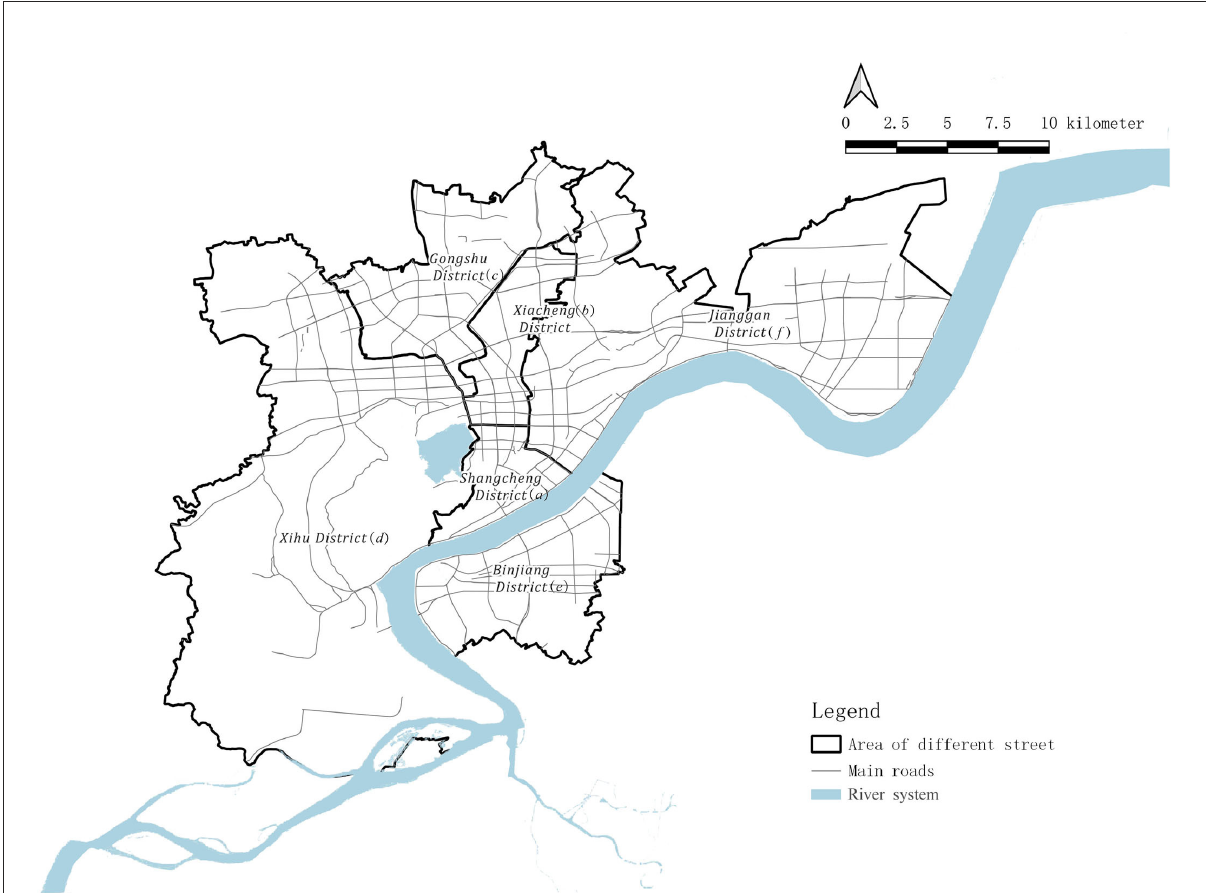
FIGURE1 Basic information of six districts in Hangzhou city (road network, river